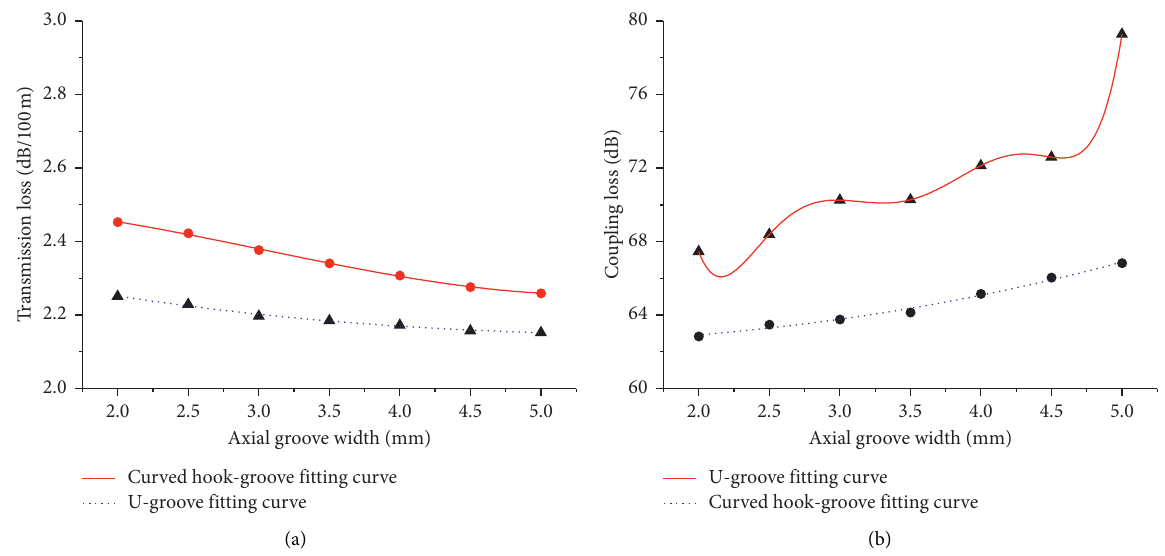
Figure 15: The influence of the axial groove width of U-groove and curved hook groove on the loss of leakage cable.